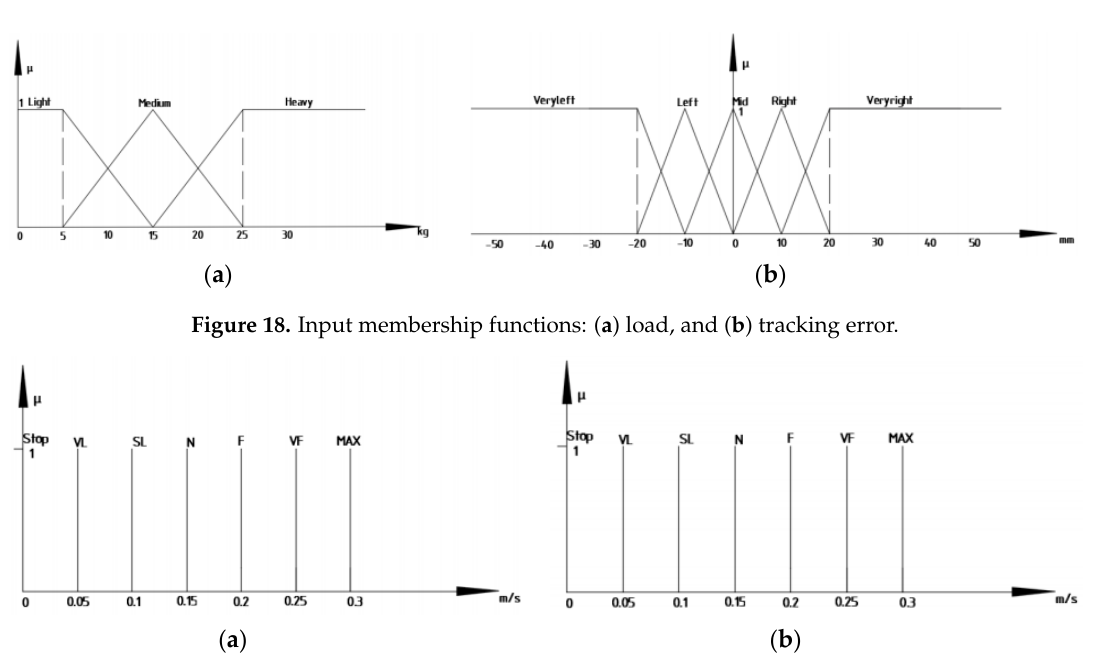
Figure 19. Output membership functions: ( a ) speed left, and ( b ) speed right. Table 3. Table of rules in fuzzy sets.